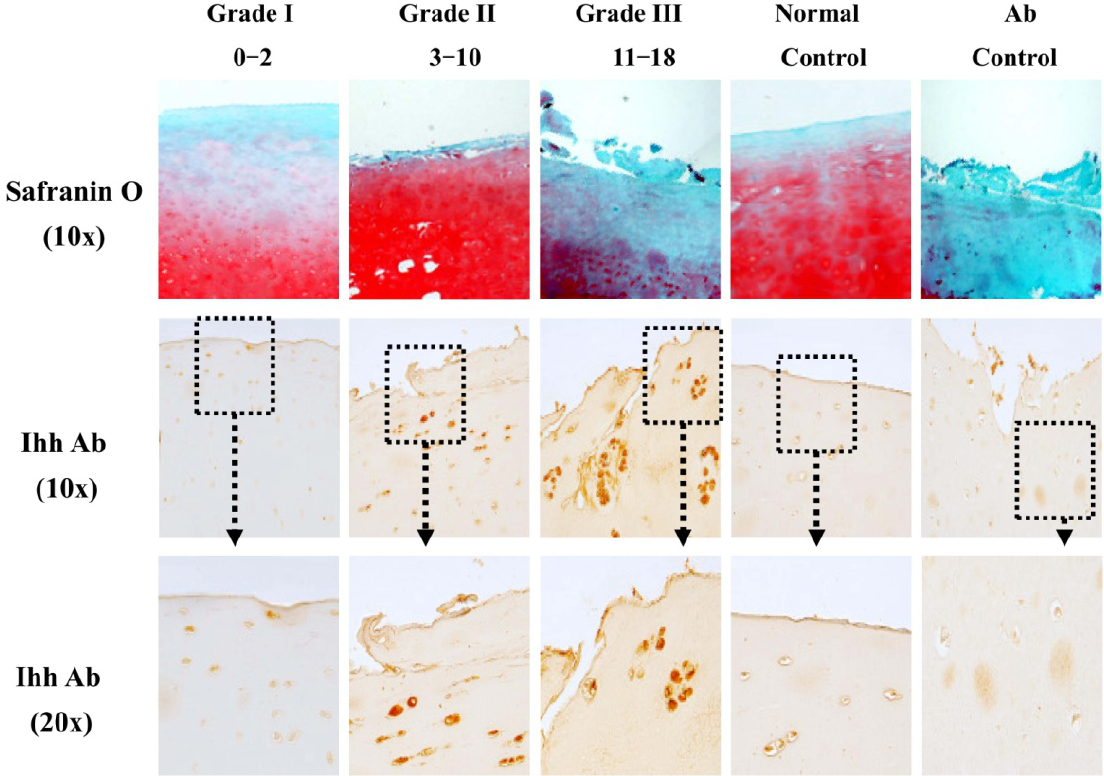
Figure 2. Increased Indian hedgehog (Ihh) expression in osteoarthritis (OA) cartilage determined by immunohistochemistry (IHC). IHC showed that the expression of Ihh is significantly increased in knee OA cartilage ( n = 15, seven males, eight females, age 63.4 ± 7.1 (mean ± SD), range 54–78) compared to resection specimens with normal cartilage ( n = 5, 4 males, 1 females, age 58.6 ± 7.7 (mean ± SD), range 49–69). A strong Ihh staining is seen in the upper layer of OA cartilage. Increased Ihh staining is associated with the severity of OA cartilage damage as demonstrated by Safranin O stain. In contrast, Ihh staining was minimal in normal cartilage. Grade I, Mankin score 0–2; Grade II, Mankin score 3–10; Grade III, Mankin score